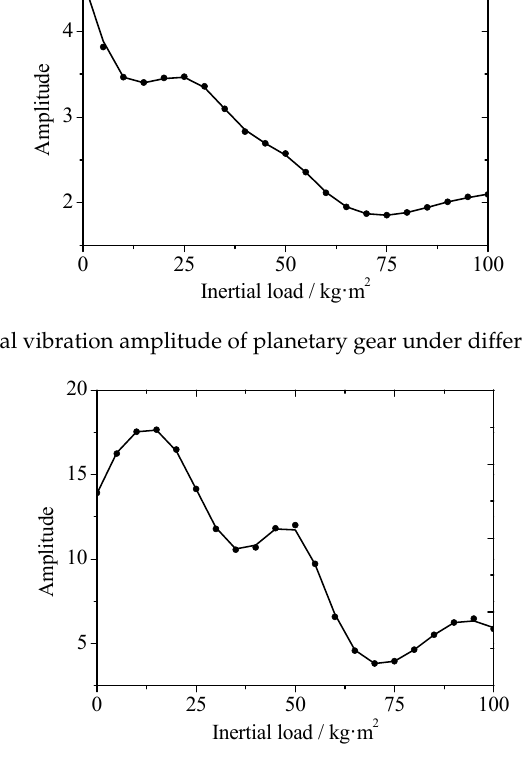
Figure 17. The amplitude of torsional vibration of planet carrier under different inertial loads.